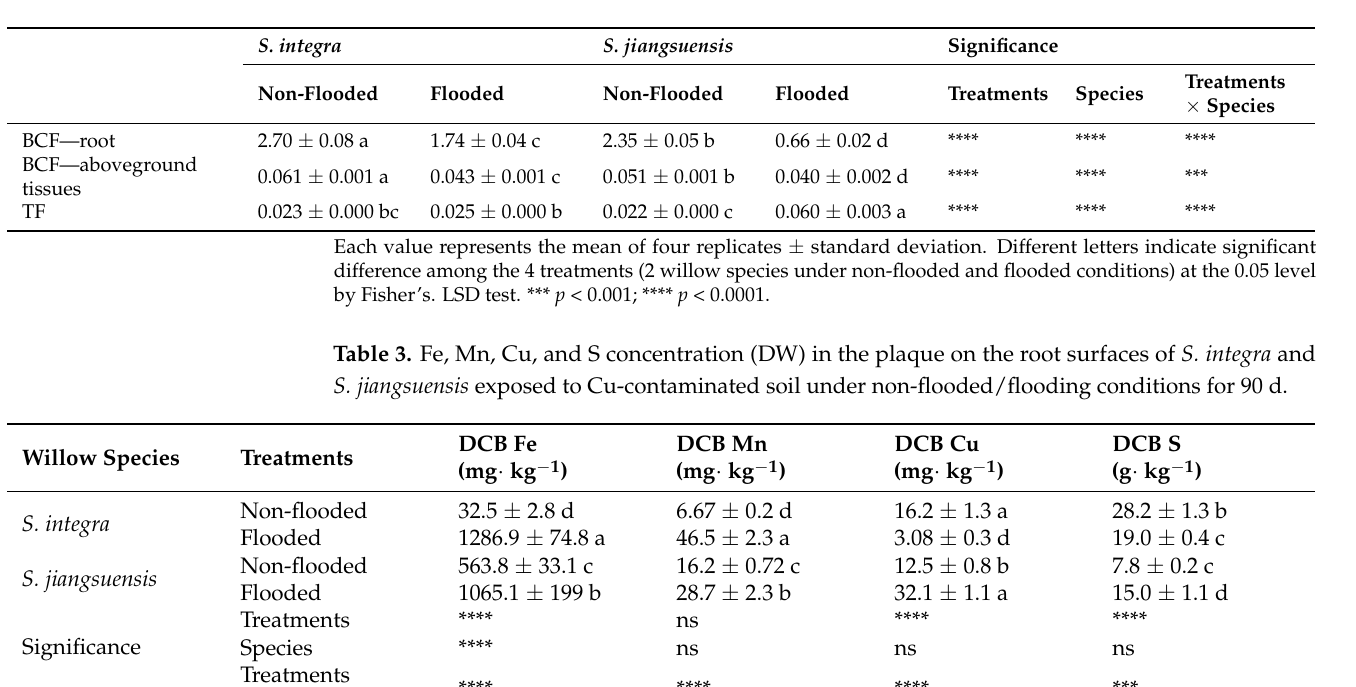
Table 2. Bioconcentration factor (BCF) and translocation factor (TF) in S. integra and S. jiangsuensis after 90 d of non-flooded/flooded treatments.